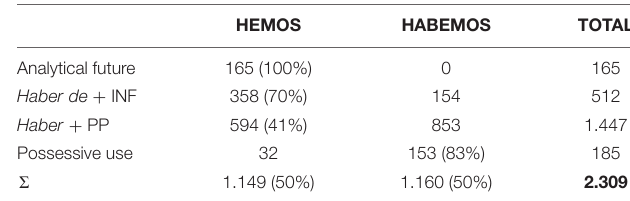
FIGURE 3 | Change in relative frequency (expressed as a percentage) for hemos (rising curve) vs. habemos (descending curve) throughout Classical Spanish.